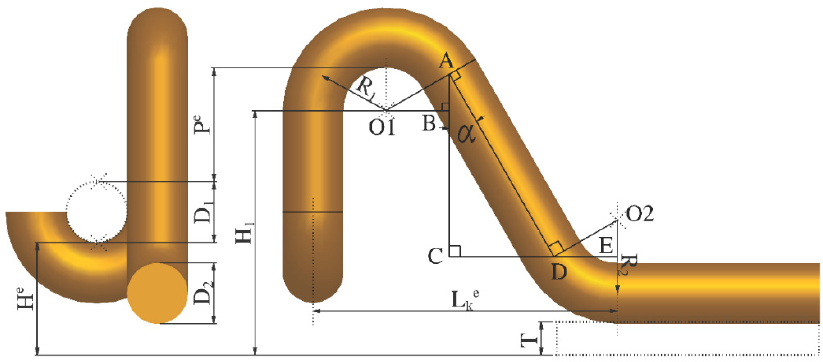
Figure A1. Calculation of inclination angle parameters for conductor wire.